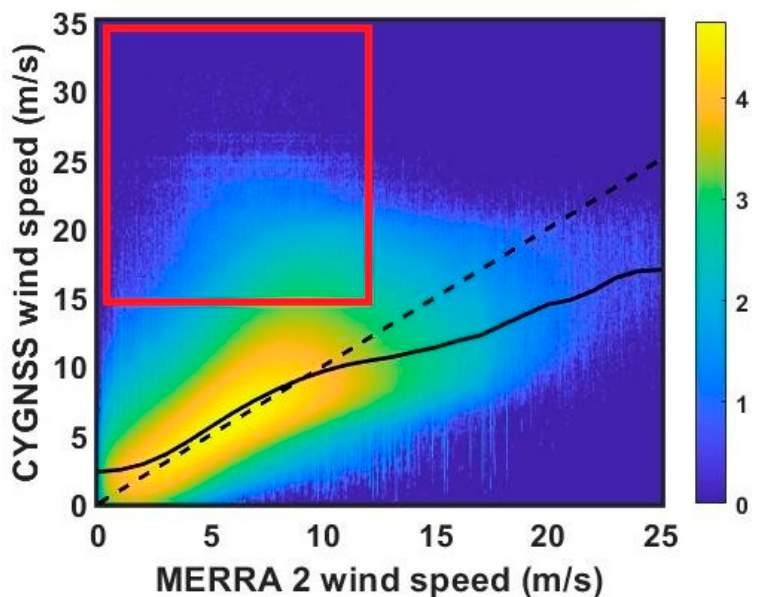
Figure 1. Log density plot of CYGNSS Level 2 retrieved winds matched to MERRA-2 reference winds for the wind speed range 0–25 m/s. The dashed line represents 1:1 agreement between the two winds. The solid line is the average CYGNSS retrieved wind at each MERRA-2 wind speed. A clustering of outliers can be seen near MERRA-2 wind speeds of 0-10 m/s and CYGNSS wind speeds >15 m/s (shown with a red box). One primary objective of the new filter is removal of this cluster.